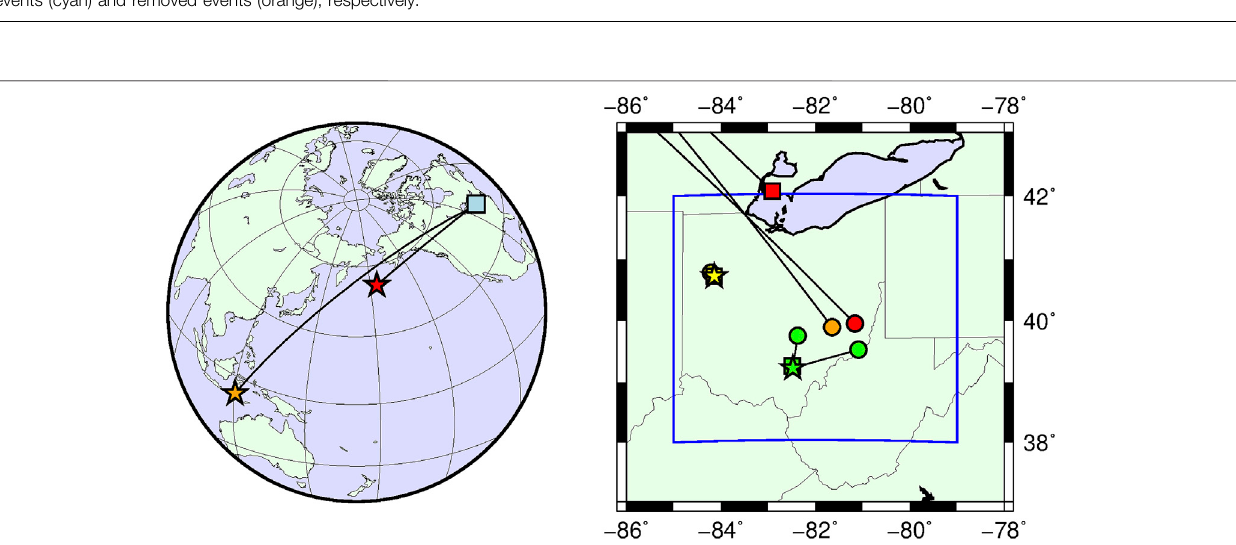
FIGURE 4 | Association results from OhioSeis. Picks triggered by two local and two teleseismic events were associated by binder_ew (circles) and binder_max (squares). Stars represent the epicenters of the earthquakes determined by the U.S. Geological Survey ’ s National Earthquake Information Center (NEIC). The region of grid search is represented by the blue solid line. Green and yellow symbols represent the epicenters of local events, while red and orange symbols depict the results for the November 24, 2019, M 6.3 Alaska Earthquake and the January 11, 2021, M 5.6 Indonesia Earthquake, respectively.